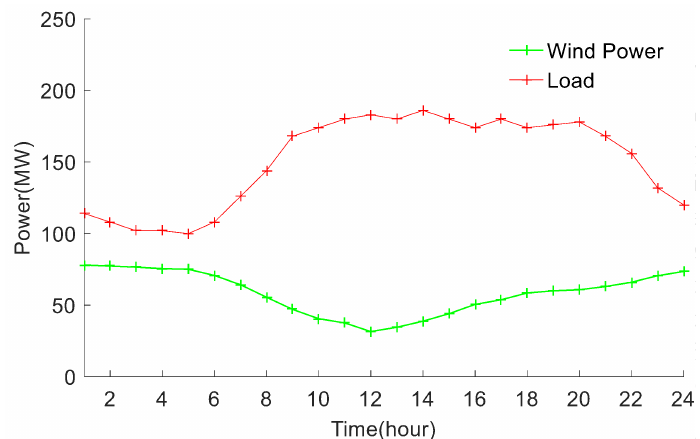
Figure 5. Forecast value of wind power and load demand of area A.